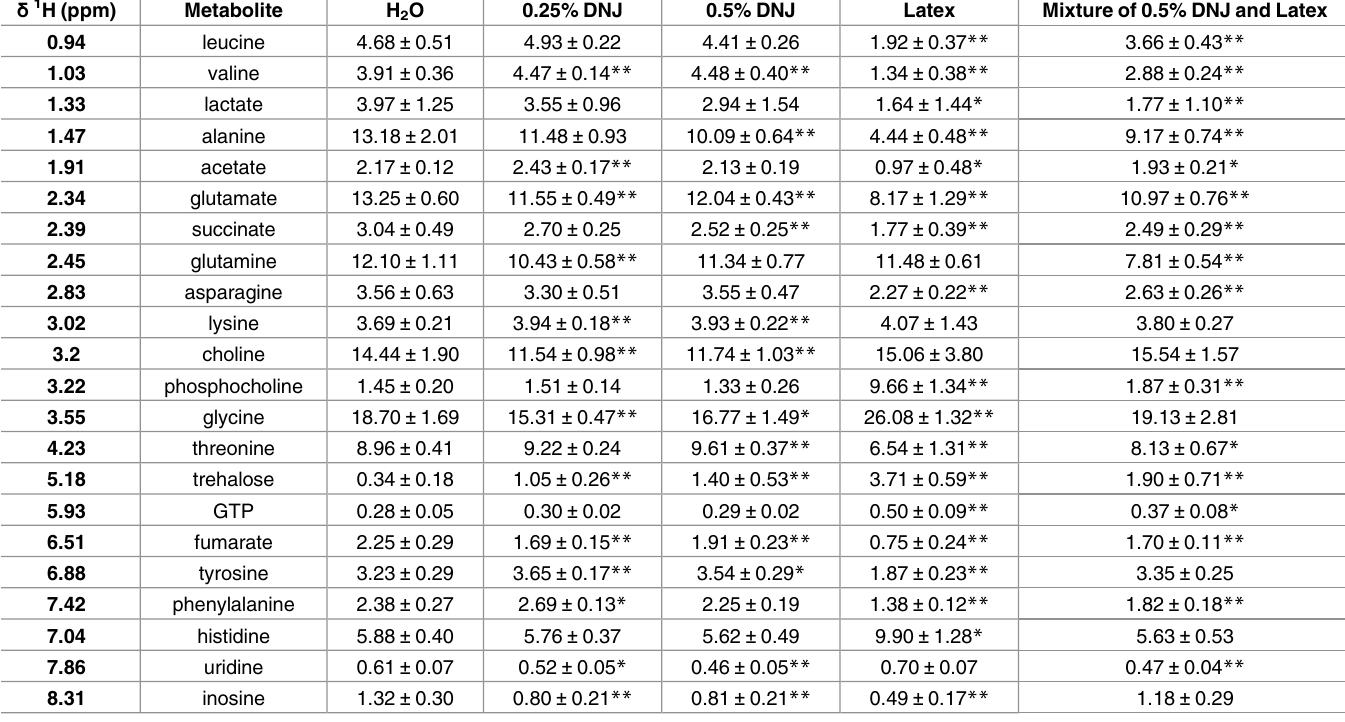
Values are expressed as mean ± SD. ** p < 0.01 respectively indicate significant differences and extremely significant differences compared with the control